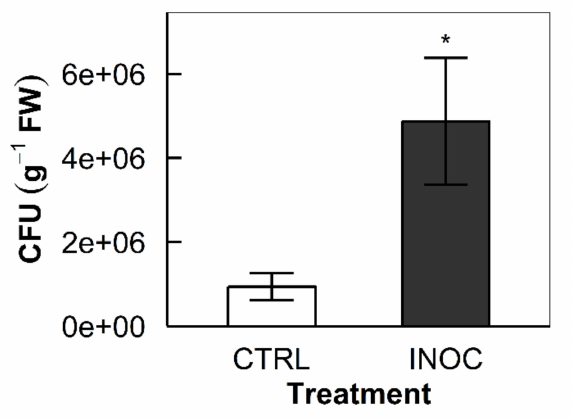
Figure 1. Colony-forming unit (CFU) counts of the apple tree tissue extracts: Bars indicate the means of the replicated samples from each treatment group ( n = 6, CTRL and INOC for mock-inoculated control and endophyte-inoculated group, respectively). Error bars represent the standard errors of the means (* p =